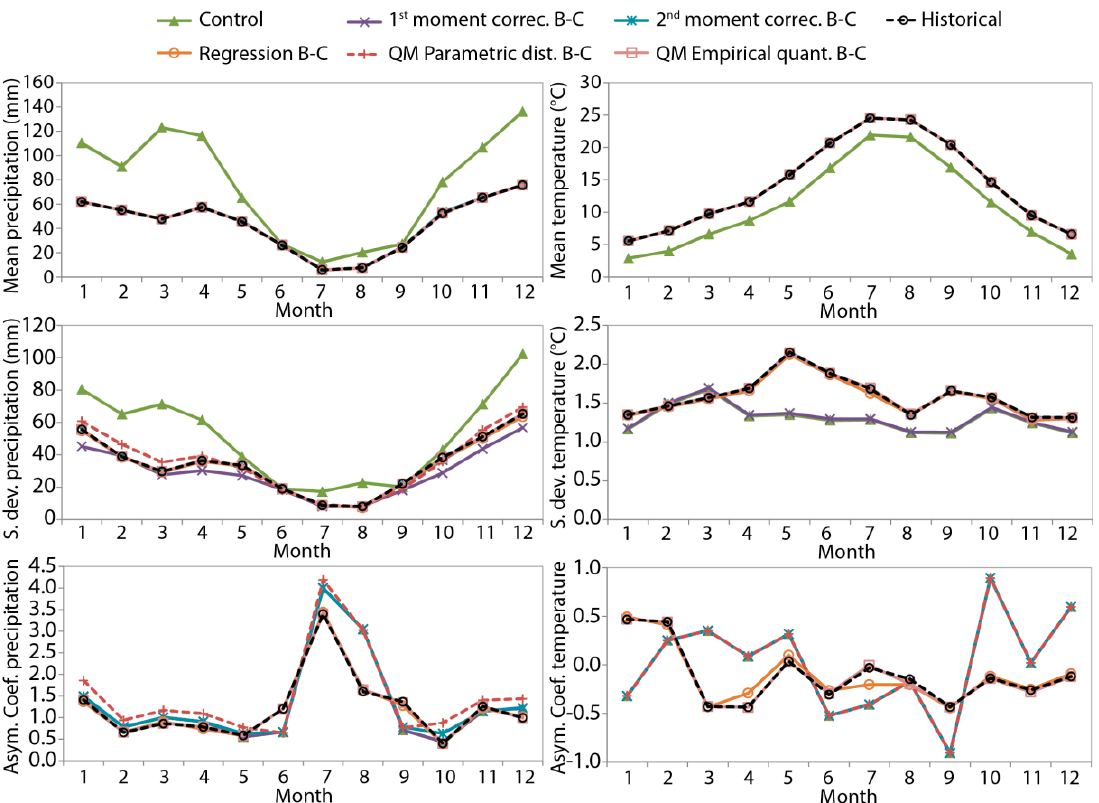
Figure 7. Mean, standard deviation, and asymmetry coefficients of the corrected control scenario (1971–2000) for precipitation (left column) and temperature (right column). Average year for HIRHAM5 RCM model nested inside EC-EARTH GCM—lumped approaches.